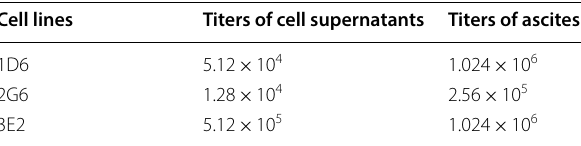
Table 2 MAbs titers of ascites and cell supernatants tested by indirect ELISA Cell lines